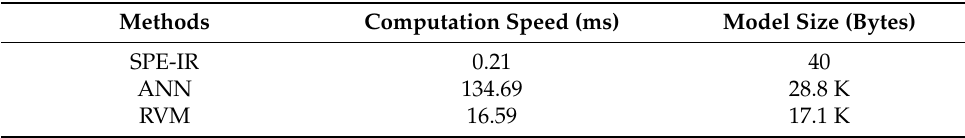
Table 10. Comparison of computation speed and model